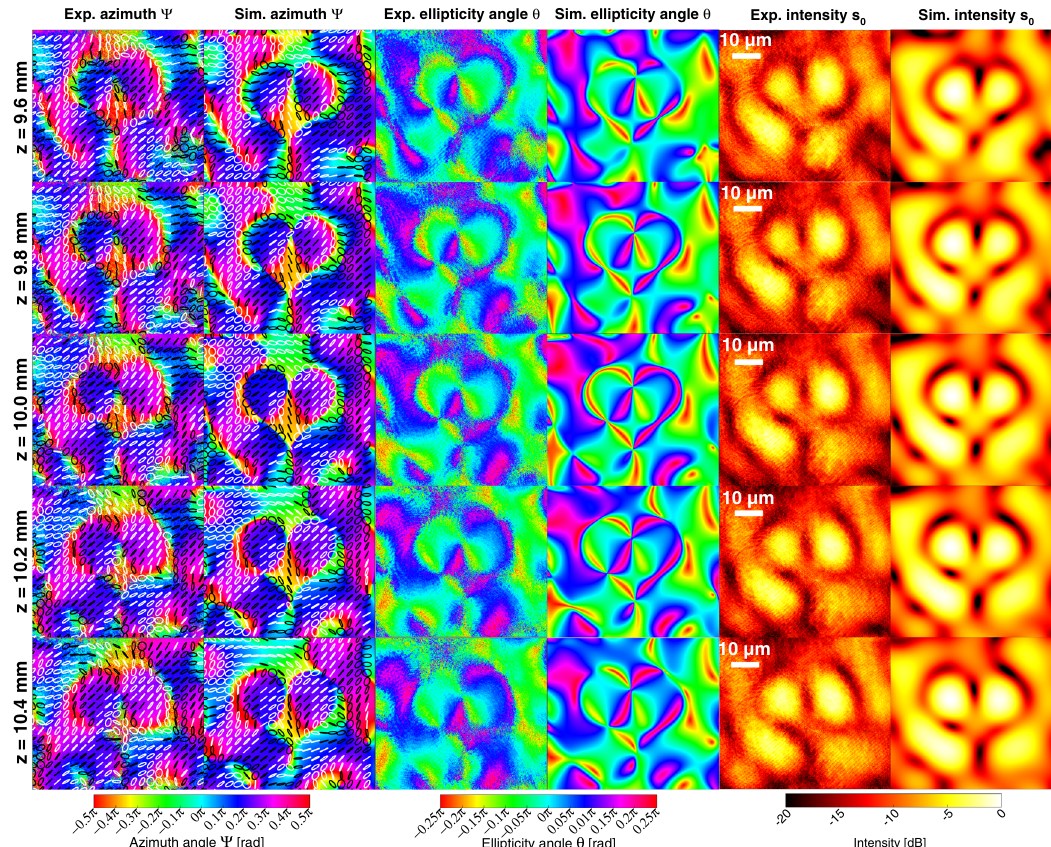
Fig. 5 An engineered heart-shaped optical polarization singularity sheet ( λ 0 = 532 nm) pro fi led at various transverse planes. The columns are, from left to right, experimental polarization azimuth Ψ , simulated polarization azimuth Ψ , experimental ellipticity angle θ , simulated ellipticity angle θ , experimental intensity ( s 0 Stokes parameter) pro fi le, and simulated intensity pro fi le. Black and white ellipses in the azimuth plots indicate the local polarization ellipses. Black ellipses indicate left-handed elliptical polarization and white ellipses indicate right-handed elliptical polarization. The experimental optical fi eld was produced by a polarization-sensitive metasurface. The images are captured at different displacements z from the metasurface along the propagating direction. The diagonal fringes in the experimental plots are artifacts arising from light diffracting around an iris in the optical